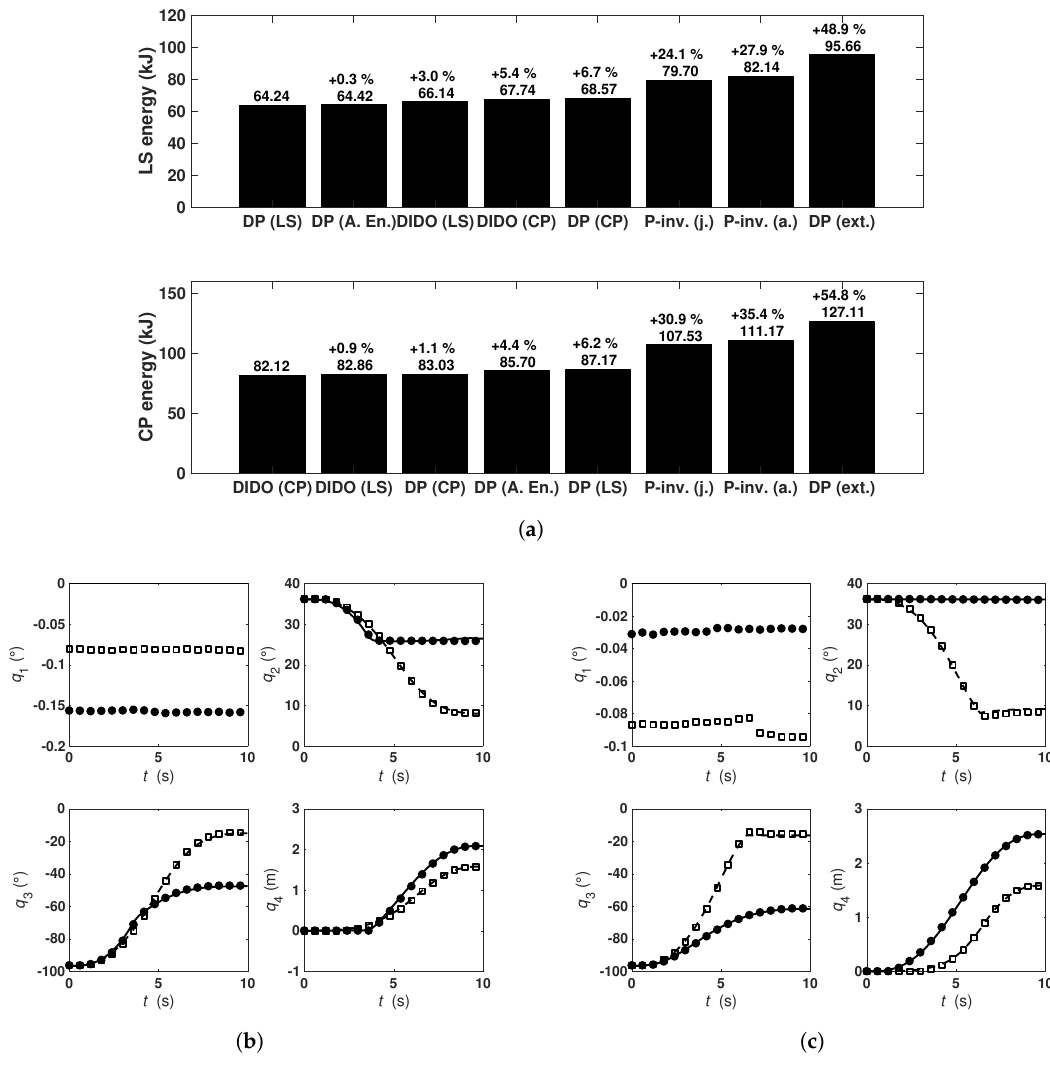
Figure 10. Horizontal path: ( a ) Experimental constant-pressure and load-sensing system energy consumptions (smallest feasible extension cylinder length at the initial configuration); ( b ) load-sensing system: energy-optimal DP (LS) joint trajectories ( ) and controller tracking performance ( Sub-optimal P-inv. (j.) joint trajectories ( ) and controller tracking performance ( (cid:151) ); and ( c ) Constant-pressure system: energy-optimal DIDO (CP) joint trajectories ( ) and controller tracking performance ( ). Sub-optimal P-inv. (a.) joint trajectories ( ) and controller tracking performance ( (cid:151) (cid:32)